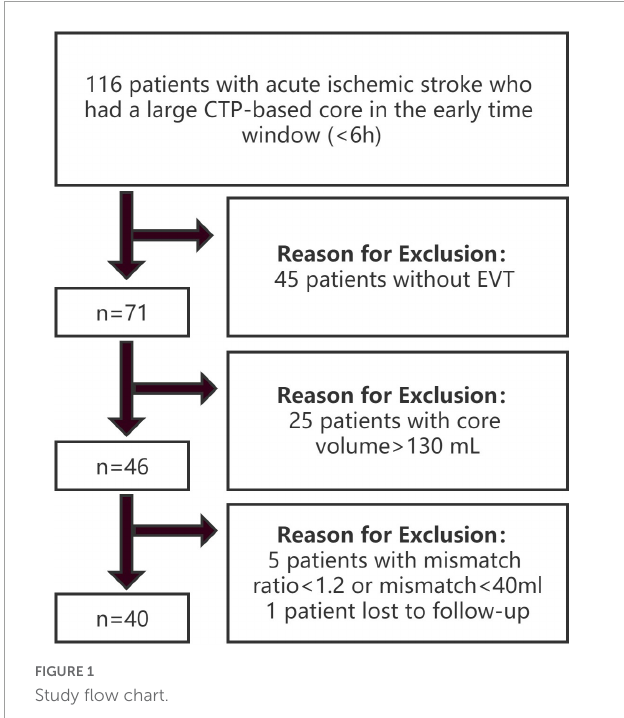
FIGURE1 Study flow chart.